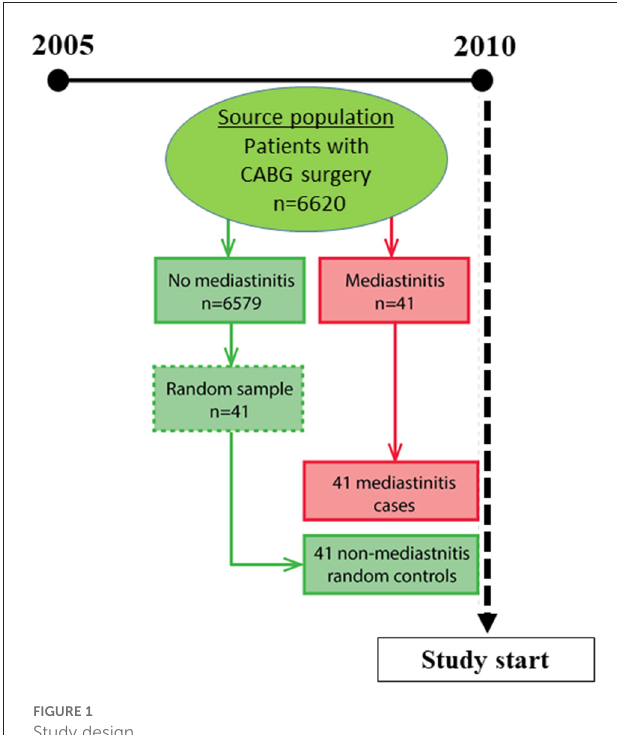
FIGURE1 Study design.